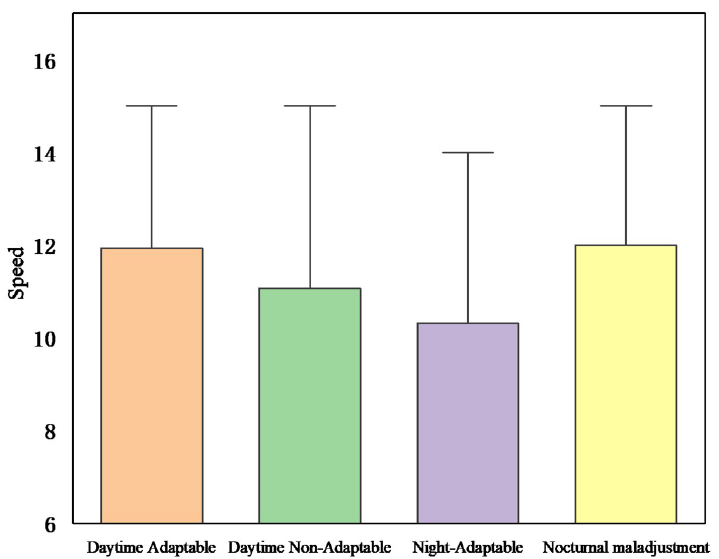
Fig 5. Speed and acceleration of driver through yellow light under